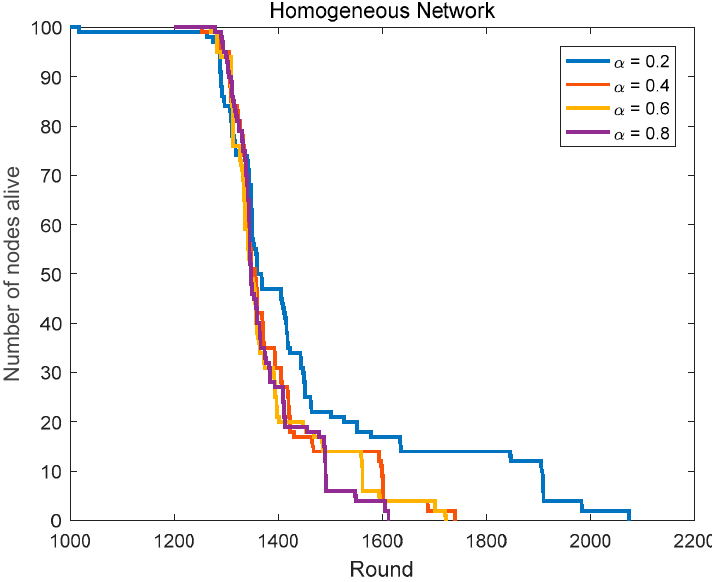
Figure 10. The network lifetime comparison in homogeneous networks (routing factor = 0.2, 0.4, 0.6 and 0.8). Table 2. A comparison of the first and last node’s death round in homogeneous networks with different routing factor α .